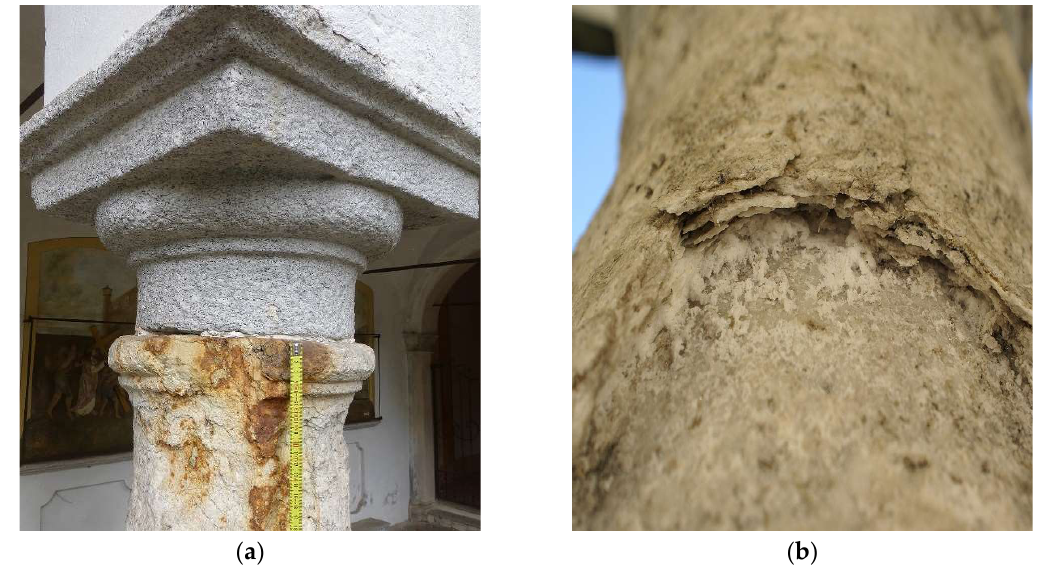
Figure 3. Examples of erosion ( a ) , exfoliation and detachment ( b ) problems in stone columns of the Via Crucis portico. The reference lexicon is that of the "Ente Nazionale Italiano di Unificazione" (UNI) Standard rules 11182:2006.